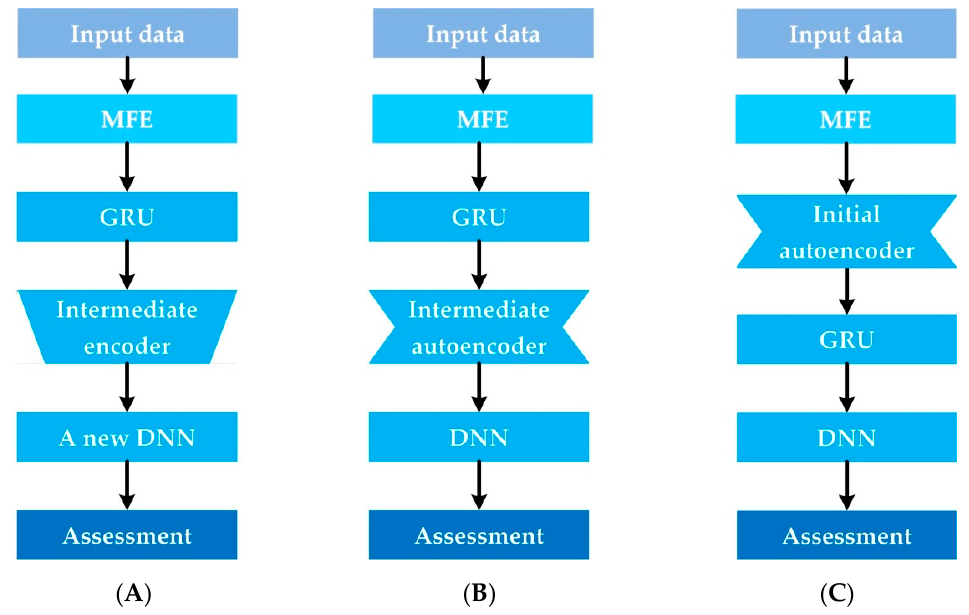
Figure 13. Dimensionality reduction encoders for GRU-DNN with MFE. ( A ) intermediate encoder; ( B ) intermediate autoencoder; ( C ) initial autoencoder.